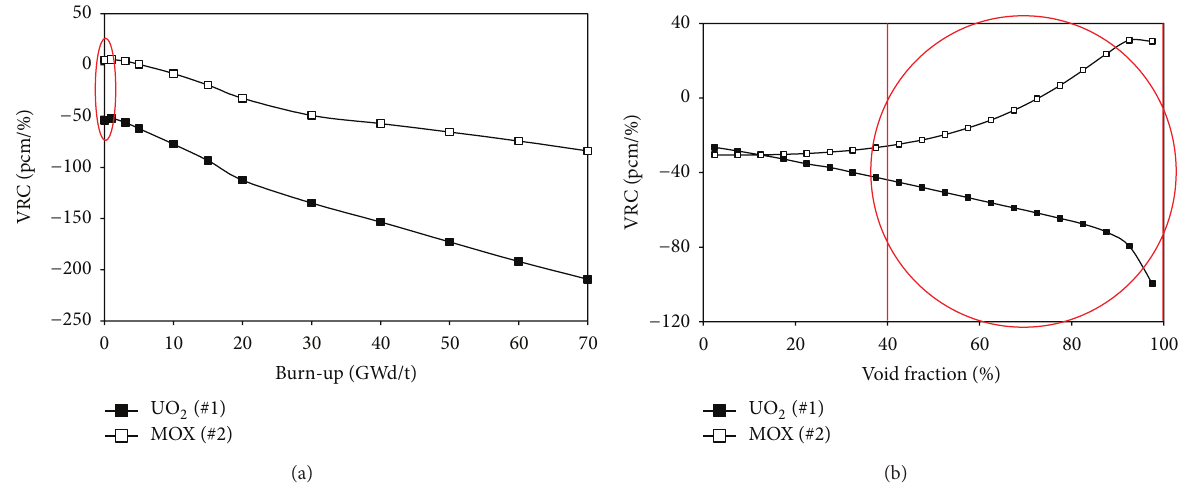
Figure 4: VRC over burn-up and void fraction for innovative fuel